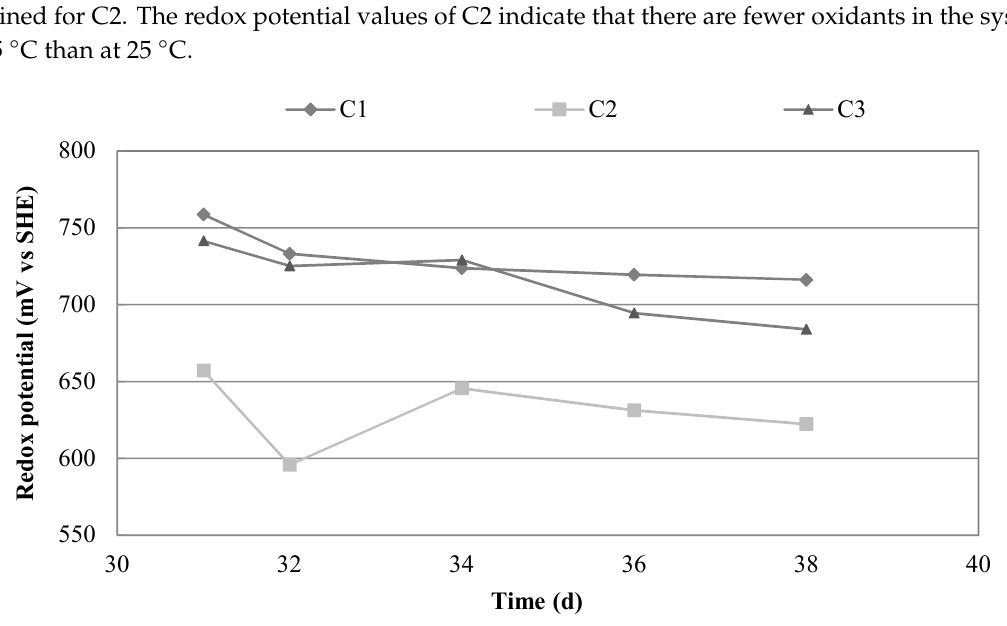
Figure 4. Redox potential (mV vs. SHE) vs. time (d) in mini-columns leaching of pretreated ore with 16.8 kg sulfuric acid/ton, 23.3 kg sodium nitrate/ton, 19.8 kg sodium chloride/ton, 30 days of curing at 45 °C. Irrigation conditions: pH 1, 6.3 g sodium nitrate/L, seawater. C1: 25 °C and 20 g chloride/L, C2: 45 °C and 20 g chloride/L, and C3: 25 °C and 40 g chloride/L.